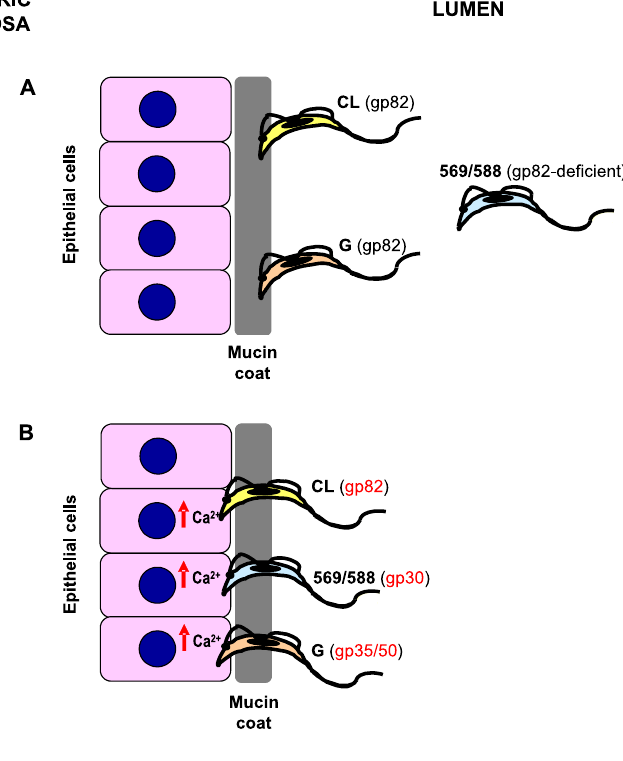
Fig. 6 – Model of molecular interaction of T. cruzi metacyclic forms with gastric mucin and gastric mucosal epithelium upon oral infection of mice. In the stomach, MT of different isolates resist destruction by pepsin and acidic pH because they are protected by protease-resistant gp35/50 mucins. A) MT of CL and G isolates bind to gastric mucin via gp82, as the first step to traverse the mucin layer and reach the underlying epithelial cells. Most parasites of gp82-deficient isolate 569 or 588 do not interact with the mucin coat, but a small number of parasites do so, in gp30 mediated manner. B) Once the epithelial cells are reached, MT of CL isolate attach to and efficiently invade them in gp82- dependent manner, whereas MT of gp82-deficient isolate 569 or 588 rely on gp30 for cell invasion. MT of G isolate enter epithelial cells poorly, due to the preferential adhesion through gp35/50, which has lower Ca 2+ signal-inducing activity than